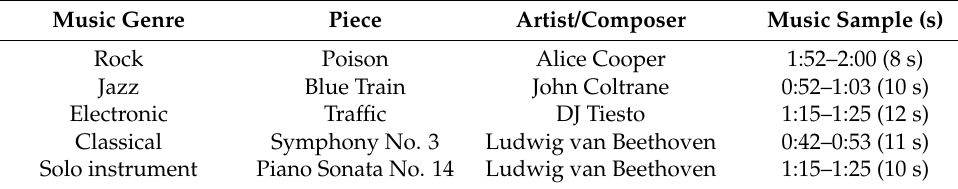
Table 1. Related information about the music excerpts used in this